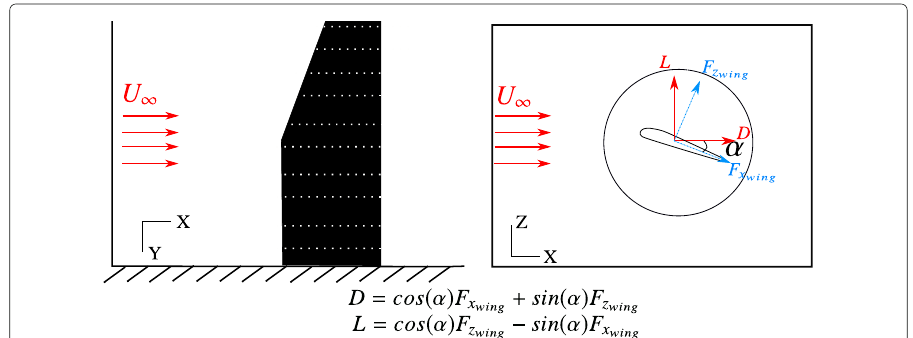
Fig. 3 Sketch explaining the rotation transformation for the force measurements